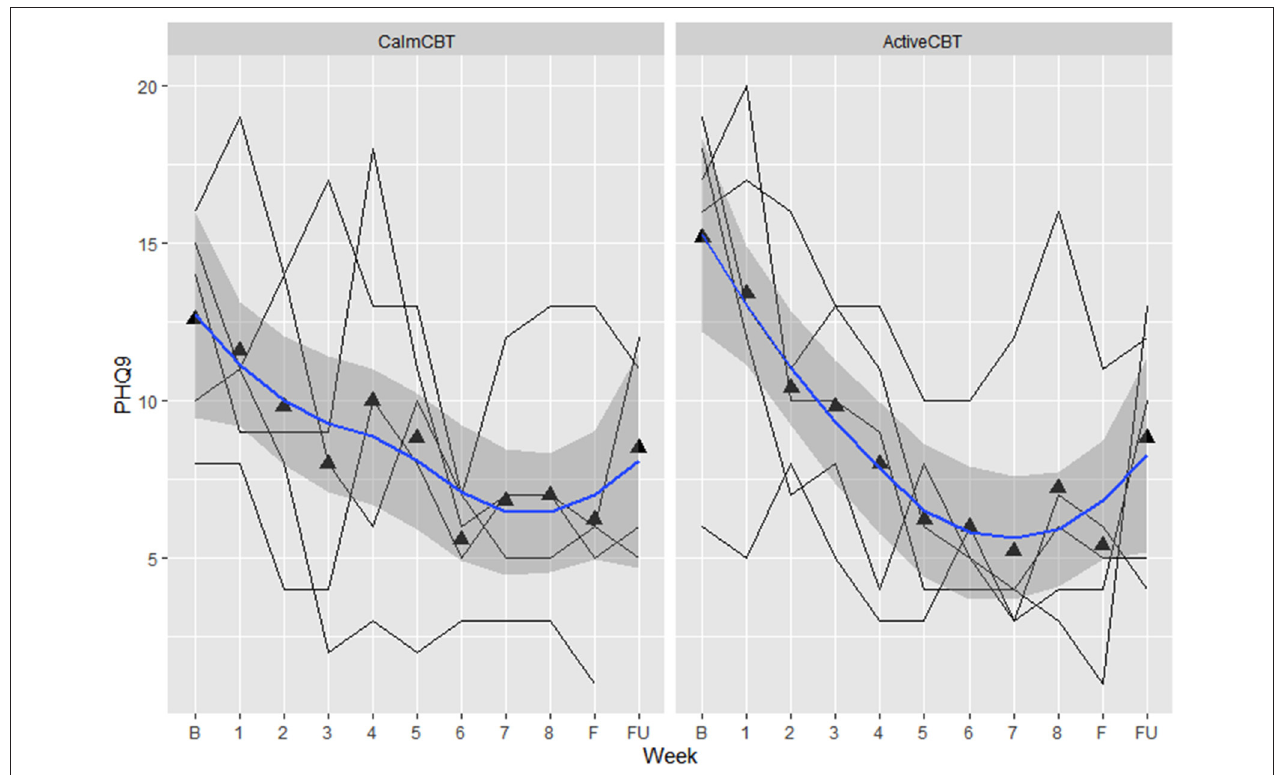
FIGURE 8 | Changes in depression symptom severity on the Patient Health Questionnaire-9 across the intervention. Data are total scores of the PHQ-9 self-reported at baseline, all 8 therapy sessions (e.g., “1” indicating “CBT Session 1”), during the final visit, and 3-month follow-up. Higher values indicate greater symptom severity, with values over 10 indicated moderate to severe depressive symptoms. B, baseline; F, final assessment; FU, 3-month